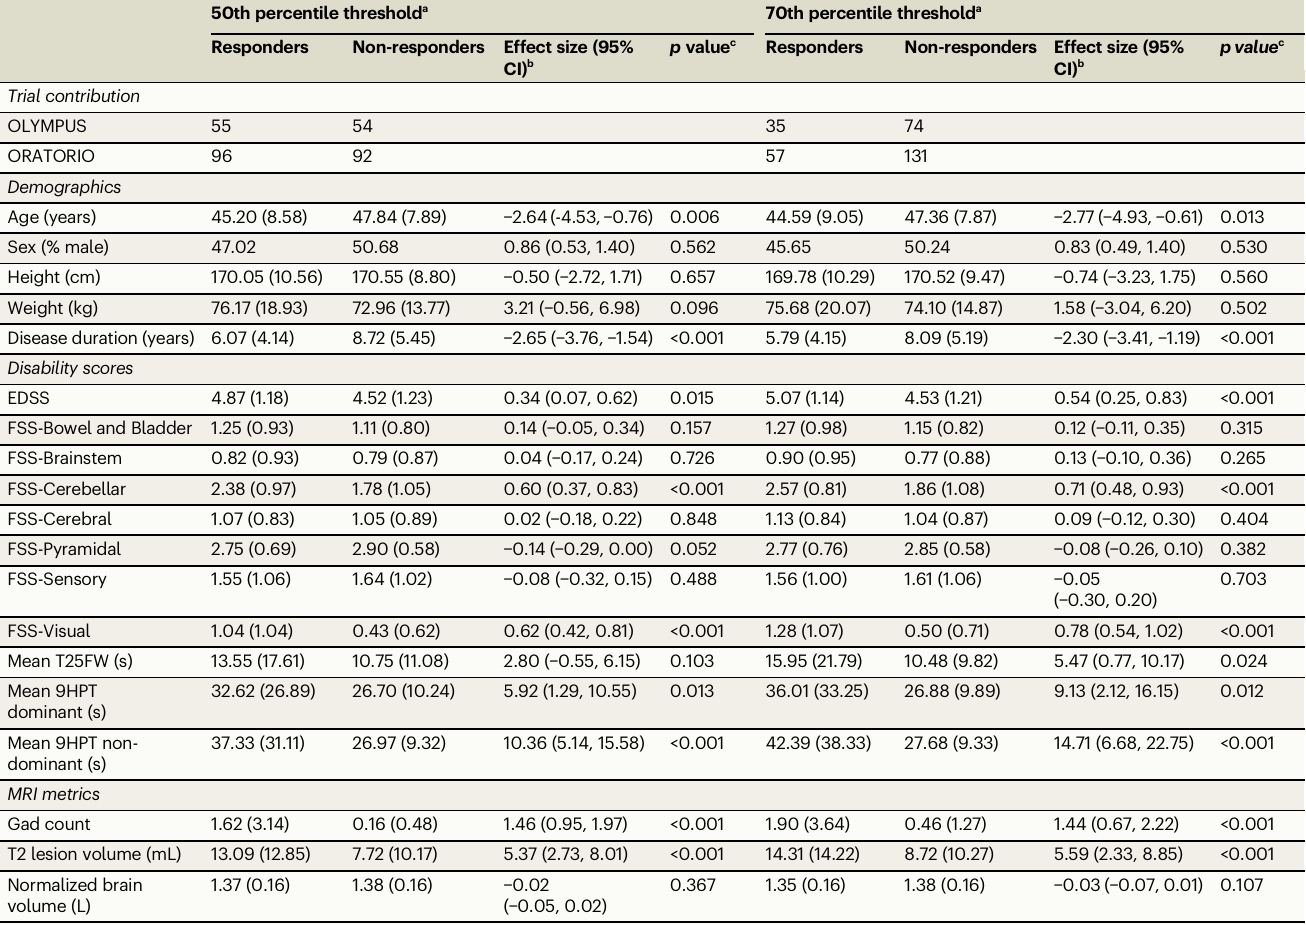
Table 2 | Group statistics for predicted responders and non-responders to anti-CD20-Abs at the 50th and 70th percentile thresholds, in the held-out test